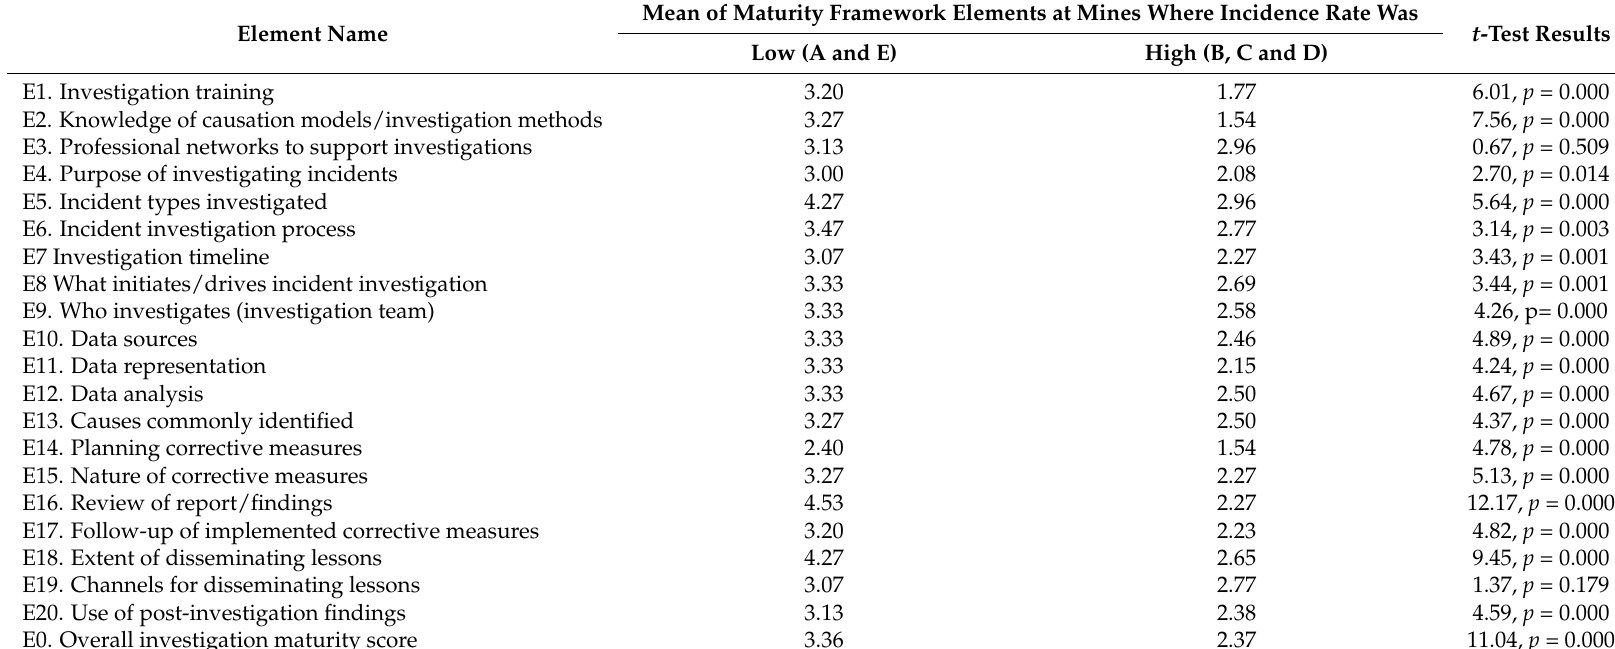
Table 6. t -Test results and mean scores of investigation elements in mines with low/high incidence rate (significant at p <